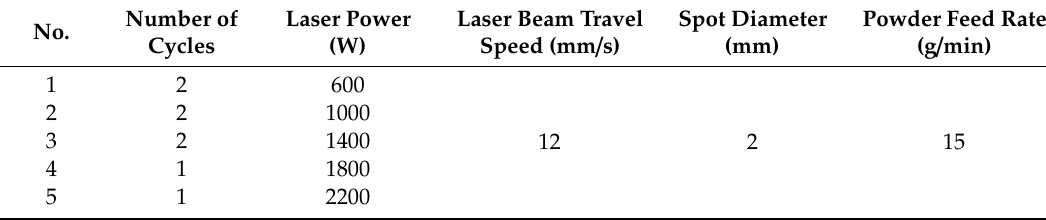
Table 1. Manufacturing parameters of coating